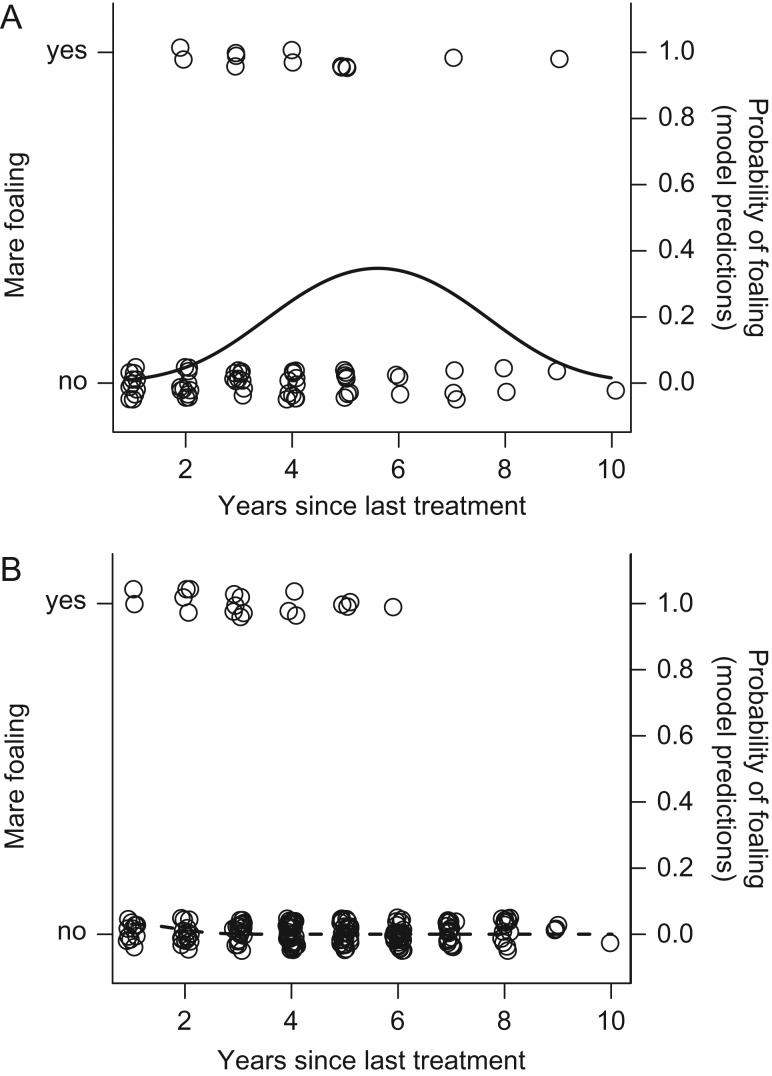
Probability of foaling after contraception suspension and mare treatment; circles represent individual births; solid and dashed lines indicate model predictions. Mares previously receiving 1–3 treatments (A) showed a gradual increase in foaling probability, peaking at ~6 years post-treatment, followed by a subsequent decrease. Mares previously receiving 4+ treatments (B) did not show a significant increase in foaling probability regardless of time since last treatment.